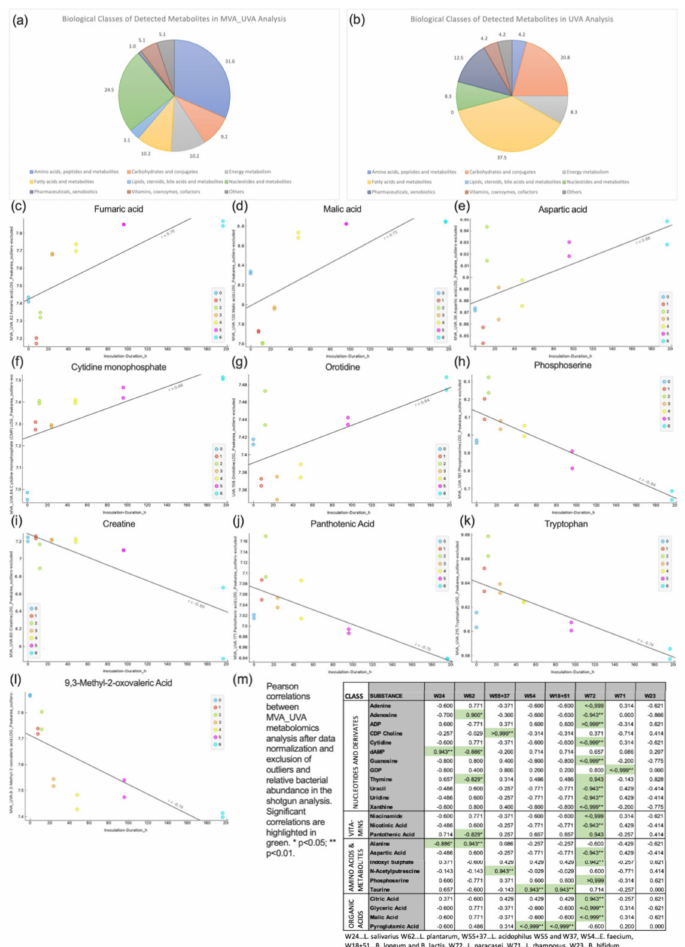
Figure 5. Metabolomics analysis; biological classes of metabolites detected in MVA_UVA ( a ) and UVA ( b ) analysis; substances with positive ( a – g ) and negative correlation ( h – l ) with inoculation time and correlation of metabolites with the relative abundance of probiotic bacteria (only metabo- lites with significant correlations are displayed) ( m ) correlation between metabolites and relative bacterial